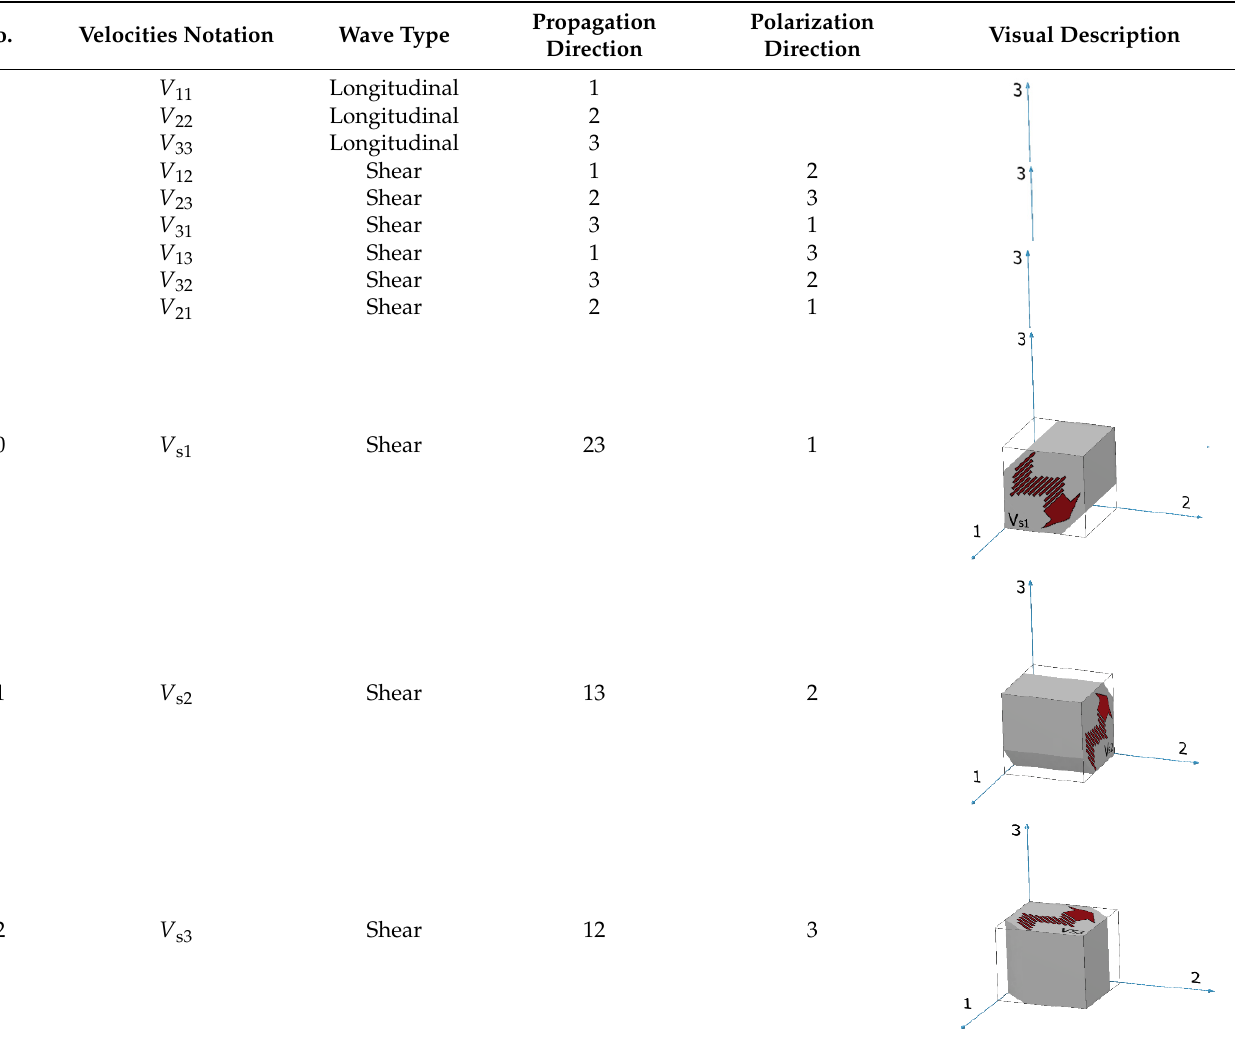
Table 1. Twelve sound wave velocities measured using the polygon method.